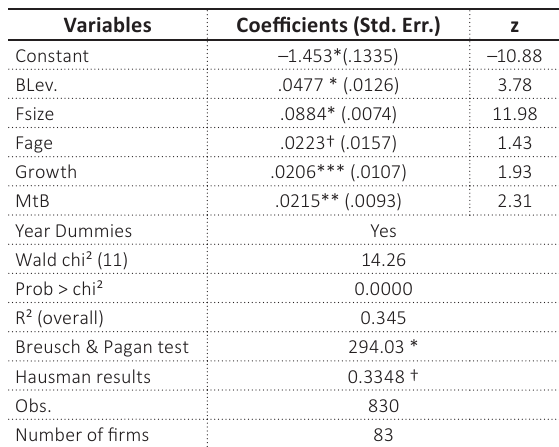
Table 4. Coefficient estimates for the association between capital structure and market